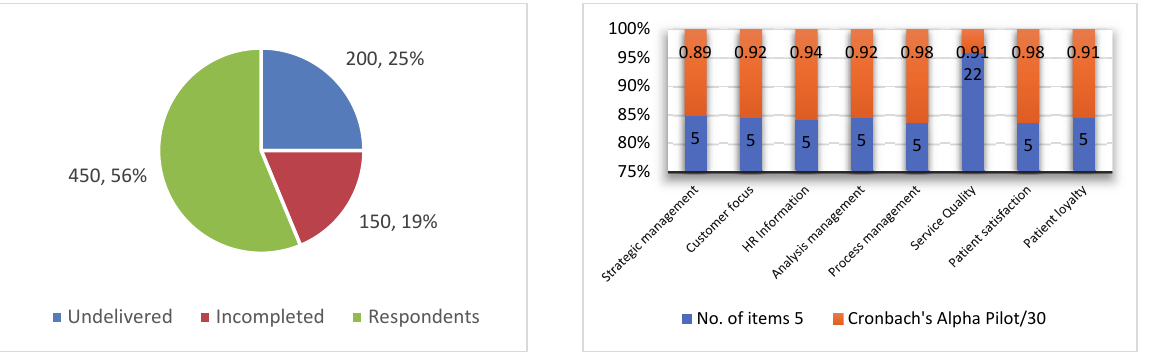
Fig. 2. Summary of Response Rates Fig. 3. The results of the pilot study